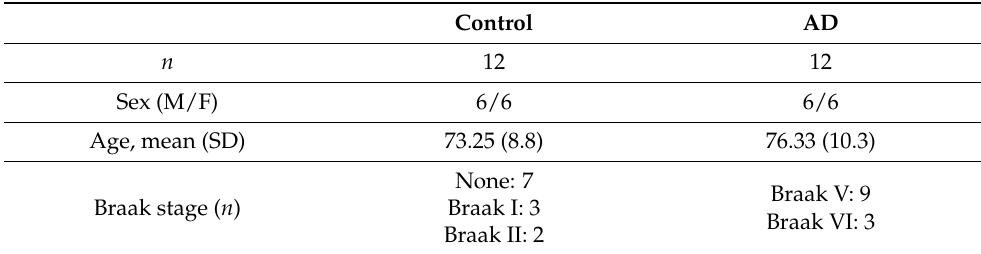
Table 2. Demographic and clinical data of brain tissue donors.